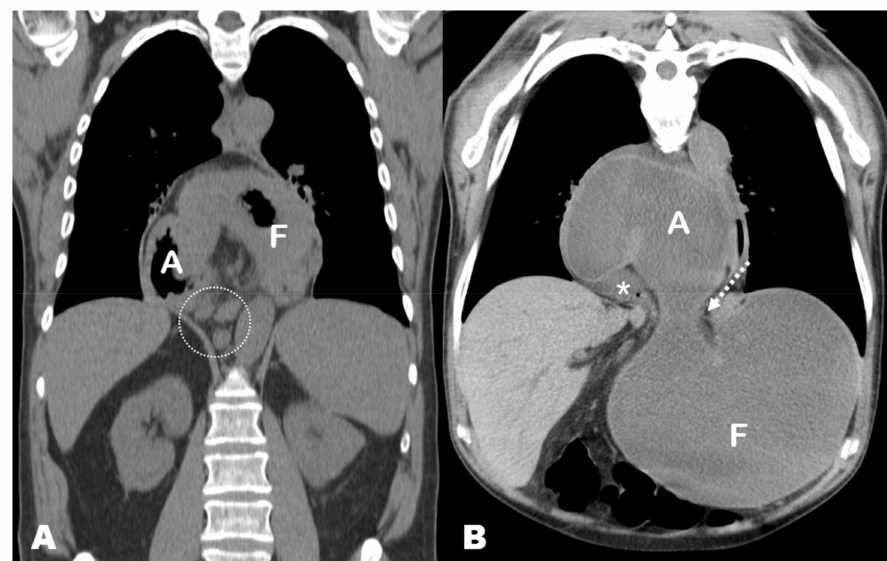
Figure 4. ( A ) PET-CT exam performed 1 month prior to the acute presentation, coronal MPR view. The entire stomach is located in the mediastinum and shows an abnormal position with the lesser curvature downwards, the antrum (A) in the right side and the fundus (F) in the left side. This has been referred to as ‘upside-down stomach’, but it is simply an exaggerated form of sliding hiatal hernia with horizontal rotation of the stomach. Note the presence of retrocrural lymphadenopathies (circle) related to a previously known patient’s lymphoma. ( B ) Non-contrast chest CT exam at the acute presentation, coronal oblique MPR view. The antrum lies above the diaphragm, and the fundus (F) is herniated through the esophageal hiatus (note the hernia neck, dotted arrow). The antropiloric junction originates from the posterior part of the antrum and lies to the right side of the esophageal hiatus (asterisk). These findings indicate that the fundus, which was previously located in the mediastinum, re-herniated into the abdominal cavity, triggering the gastric